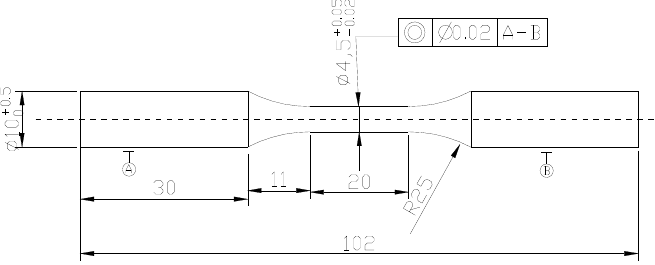
Figure 1. Detailed drawing of push–pull fatigue sample.